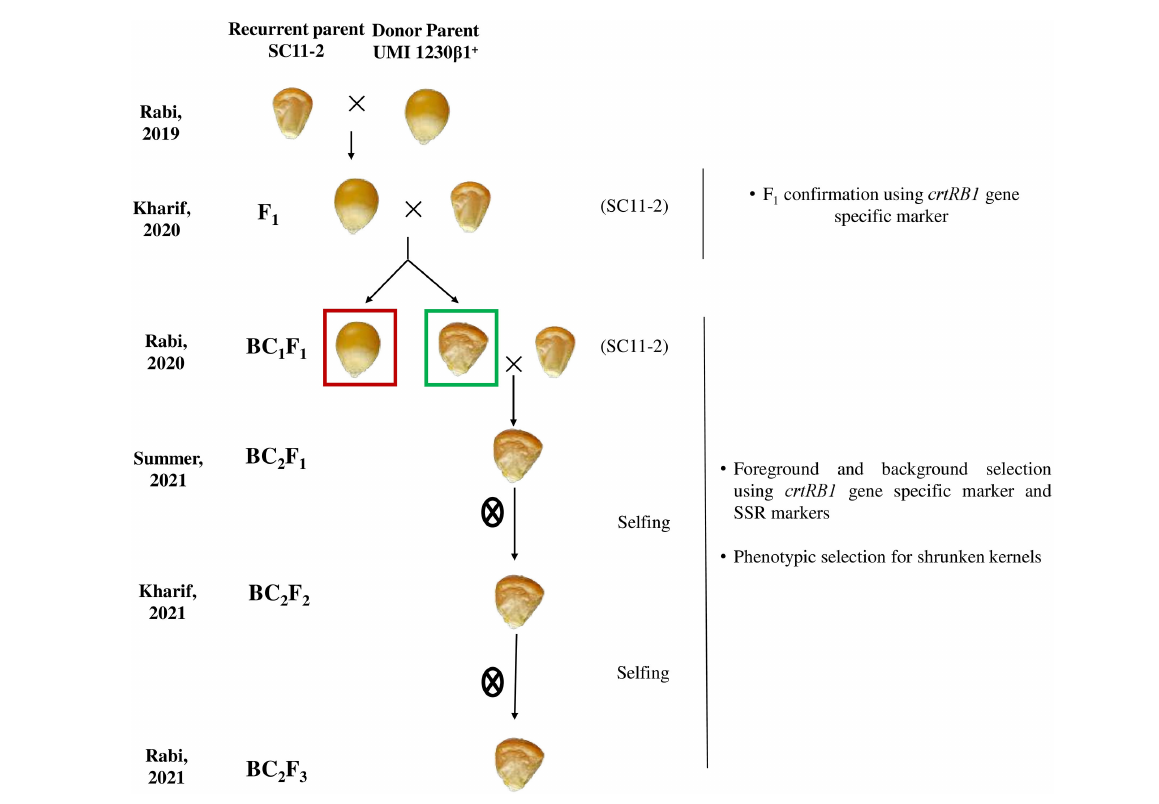
FIGURE1 The selected flint kernel in the F 1 generation is backcrossed with the recurrent parent (SC11-2). The shrunken kernel is selected (highlighted with green color box) in BC 1 F 1 and these shrunken kernels are selected and selfed in the subsequent